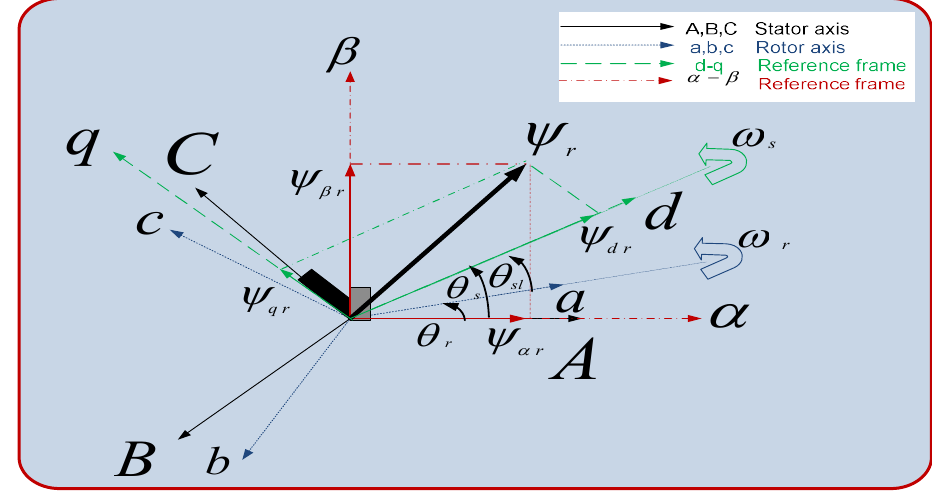
Figure 4. Transformation of the rotor flux vector.